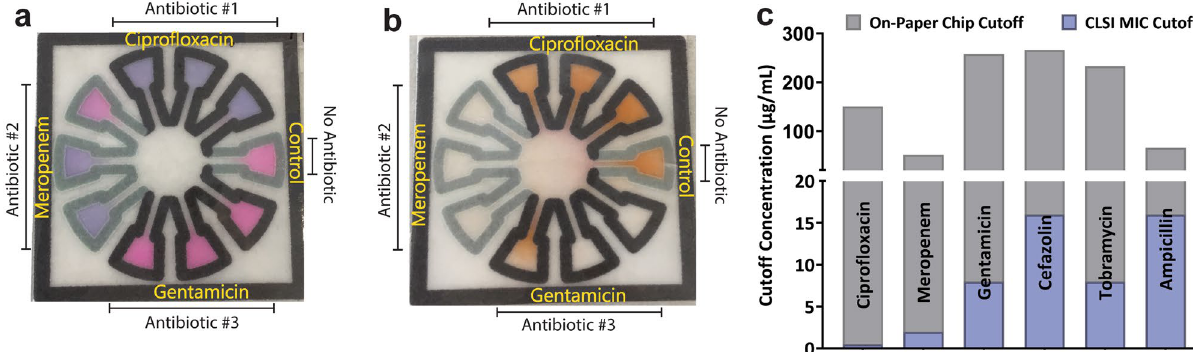
Figure 1. Bac-PAC design. ( a ) Example test using PrestoBlue dye displaying ciprofloxacin susceptible, meropenem susceptible, and gentamicin resistant results. ( b ) Example test using XTT dye displaying ciprofloxacin resistant, meropenem susceptible, and gentamicin susceptible results. ( c ) Concentrations used on paper chip (top, grey) compared to CLSI MIC liquid culture cut-offs (bottom,